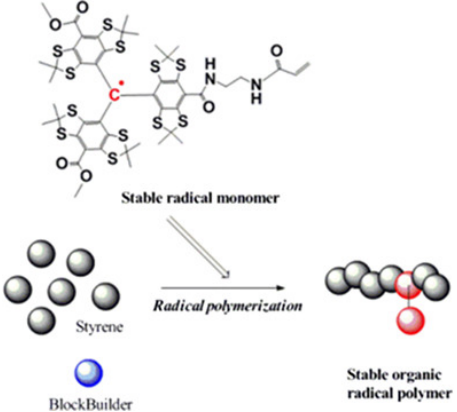
Figure 12. Preparation of stable organic radical polymer (SORP) using conventional radical polymerization and NMP. Reprinted with the permission of Wiley from ref.